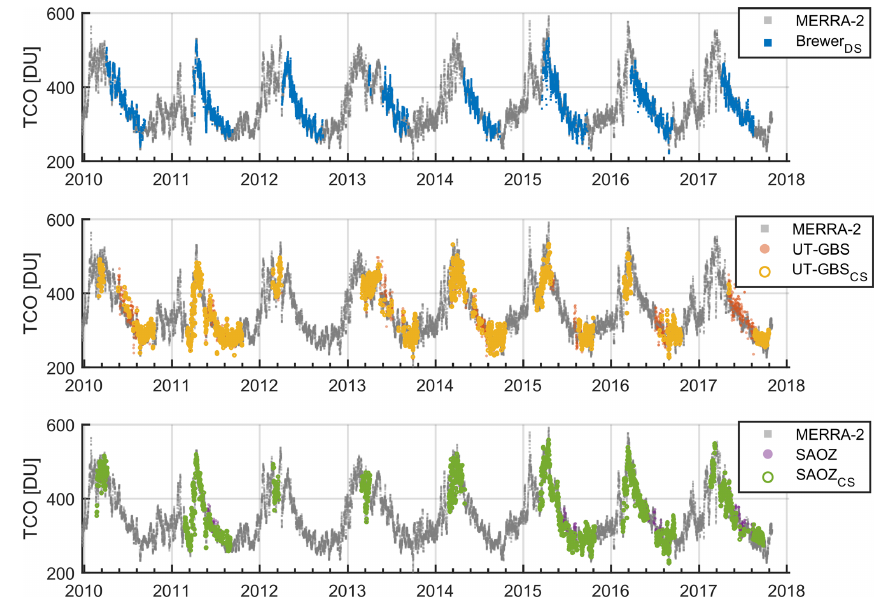
Figure 4. Time series of measured and modelled total column ozone (TCO) at